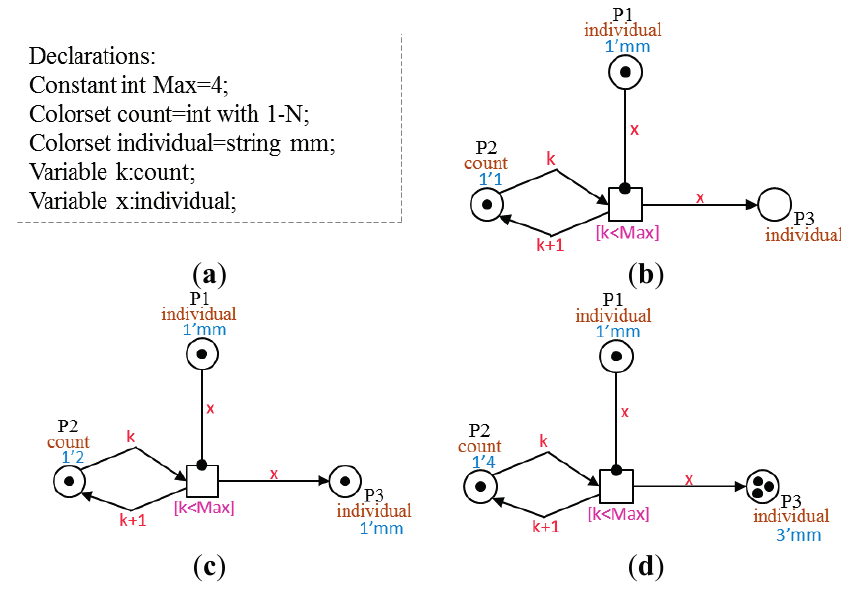
Figure 2. Colored Petri net example. ( a ) Declarations of the data types and variables; ( b ) Colored Petri net components; ( c ) State of the net after firing the transition once; ( d ) End state of the net; the transition is not able to fire since the condition of the guard is not